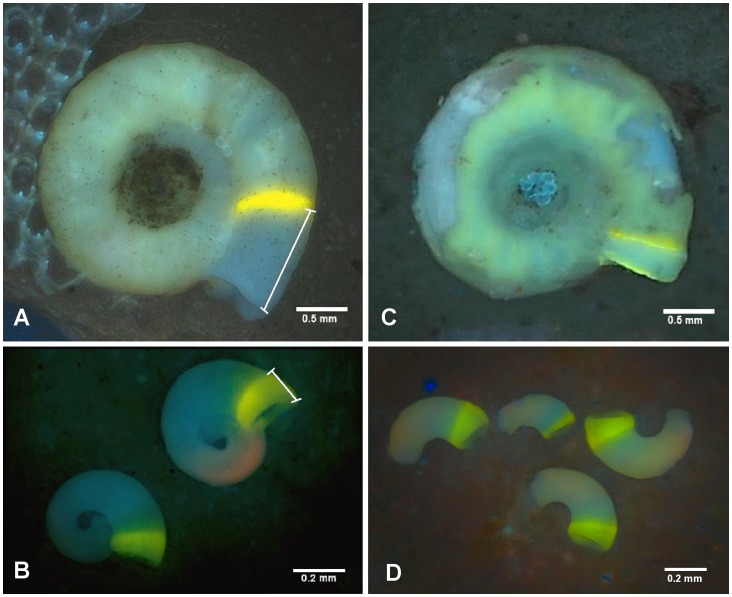
Illustrative examples.(A, C) Adult S. spirorbis tubes after 30 days of incubation at 460 µatm and 3150 µatm pCO2 respectively. (B, D) Juveniles S. spirorbis tubes after 30 days of incubation at 460 µatm and 3150 µatm pCO2. Note the conspicuous dissolution of the shell in (C) and the disappearance of part of the tube in (D). All photos were taken under epifluorescence microscope, yellow/green: calcein staining. The white lines show the considered distances for the growth measurements of S. spirorbis tubes.